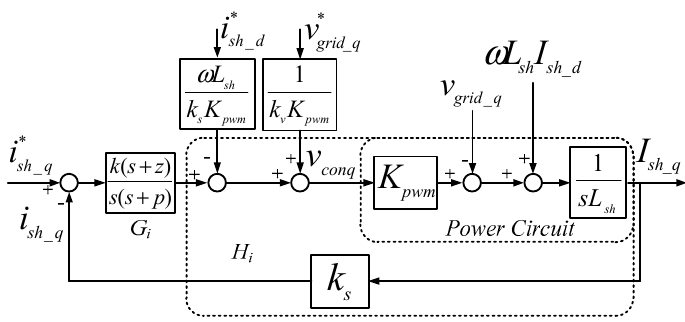
Figure 3. Block diagram of q-axis current controller.